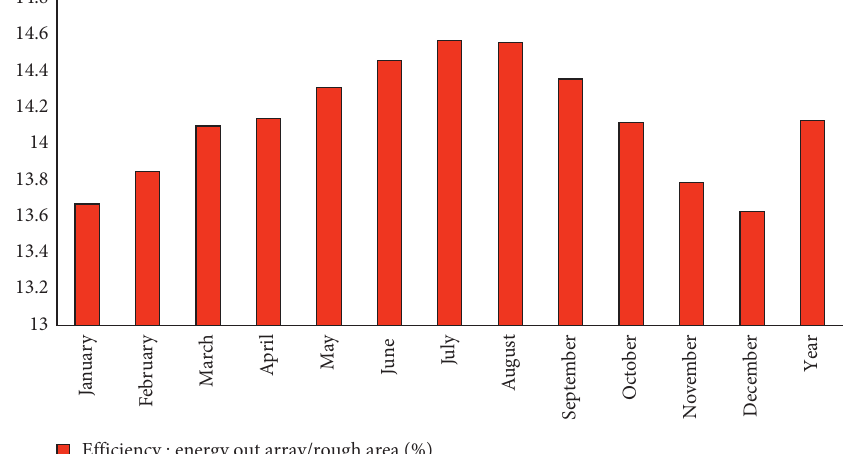
Figure 7: Assessment of ENSET PV array efficiency based on PVSYST software for each individual month of the